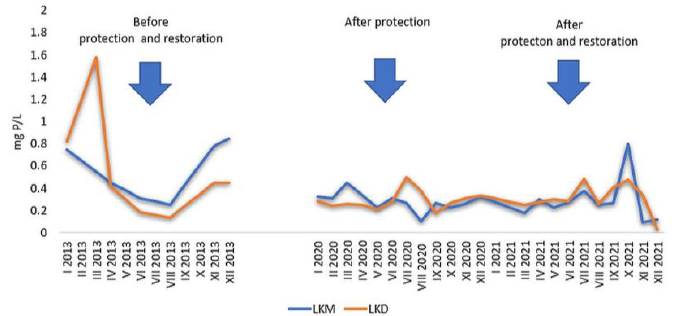
Figure 12. Changes in the content of TP in the surface water layer of Klasztorne lakes in selected research years. research